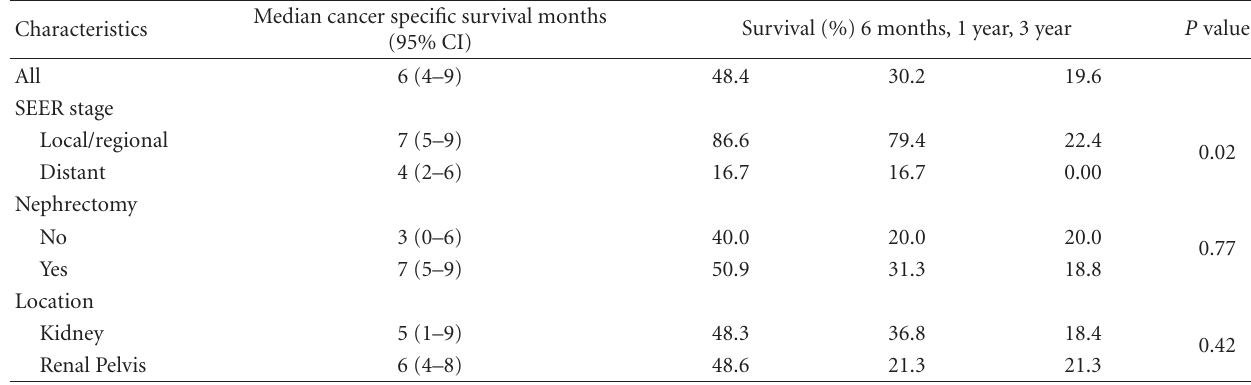
Table 2: Median, 1-, 3-year cancer specific survival of patients with carcinosarcoma of kidney and renal pelvis (CSKP) according to demo- graphic and clinical characteristics.